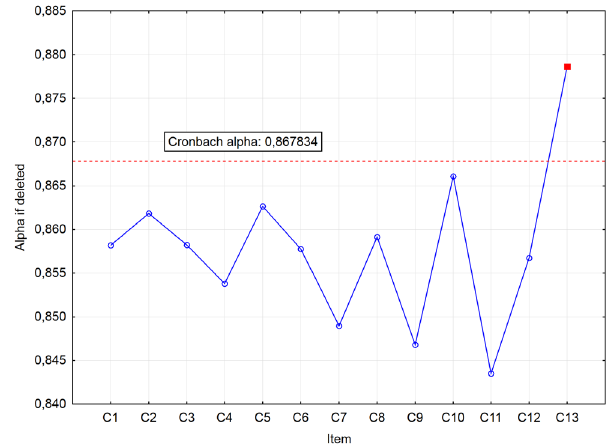
Fig. 1. Changes of the questionnaire reliability coefficient value after elimination of the rele- vant questionnaire